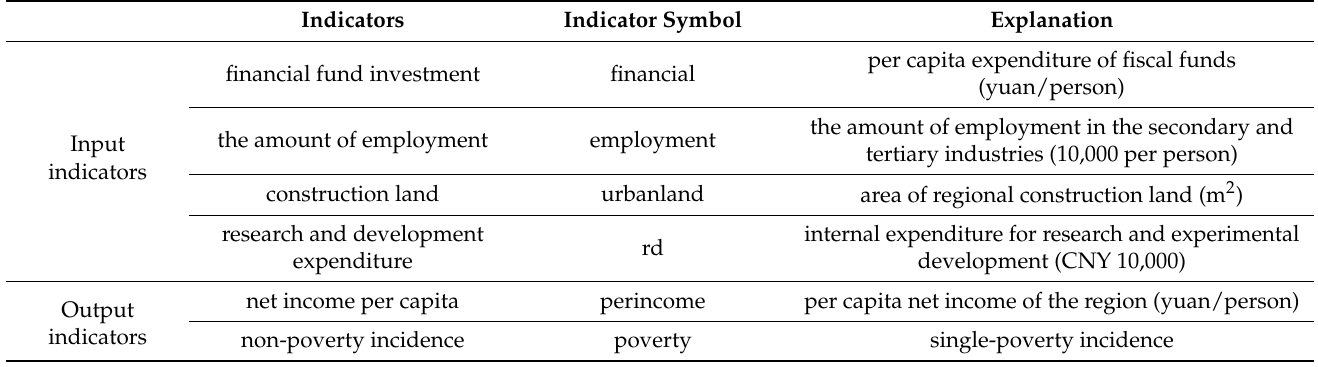
Table 1. DEA model-specific indicators of poverty reduction efficiency in state poverty